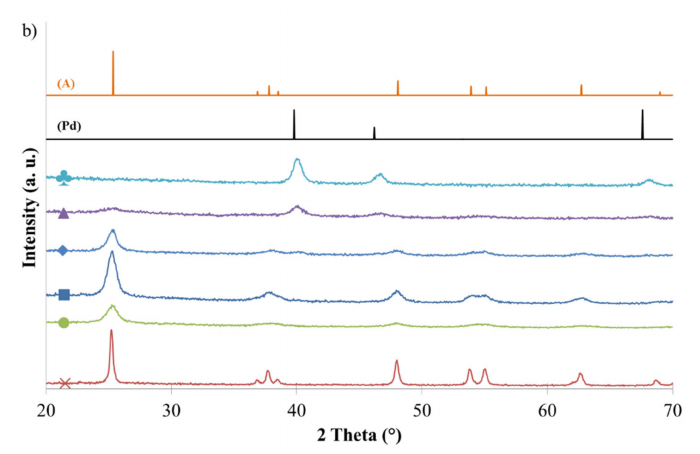
Figure 1. ( a ) XRD patterns of calcined samples: ( × ) pure TiO 2 , ( • ) TiO 2 / SiO 2 , ( (cid:4) ) TiO 2 / SiO 2 / Pd1, ( (cid:7) ) TiO 2 / SiO 2 / Pd5, ( (cid:78) ) TiO 2 / SiO 2 / Pd12, and ( ♣ ) TiO 2 / SiO 2 / Pd22; and ( b ) XRD patterns of reduced samples: ( × ) pure TiO 2 —H 2 , ( • ) TiO 2 / SiO 2 —H 2 , ( (cid:4) ) TiO 2 / SiO 2 / Pd1—H 2 , ( (cid:7) ) TiO 2 / SiO 2 / Pd5—H 2 , ( (cid:78) ) TiO 2 / SiO 2 / Pd12—H 2 and ( ♣ ) TiO 2 / SiO 2 / Pd22—H 2 . (A) Reference pattern of anatase, (PdO) reference pattern of palladium oxide and (Pd) reference pattern of palladium.